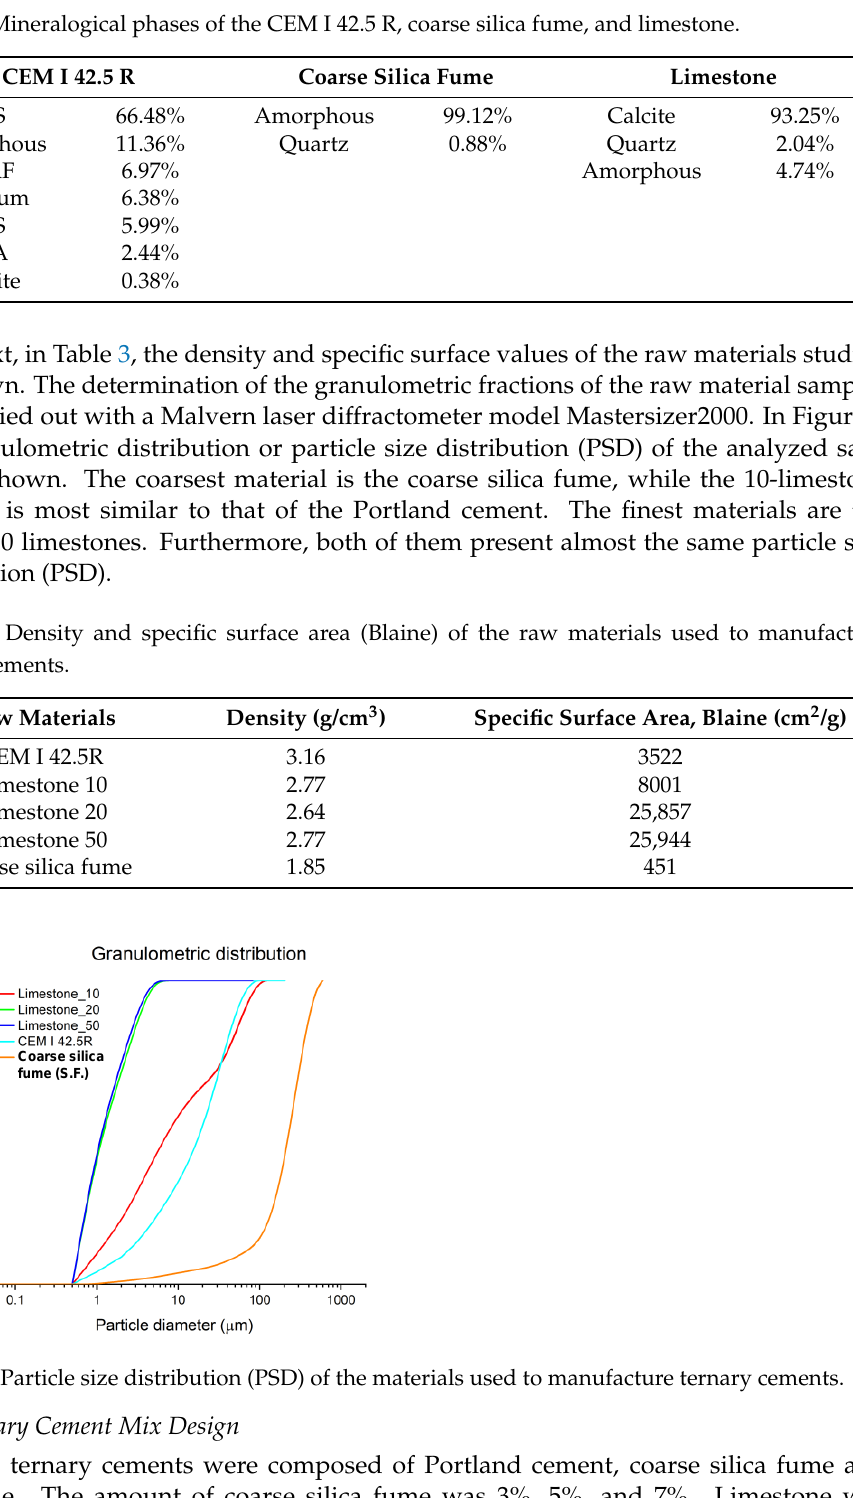
Table 2. Mineralogical phases of the CEM I 42.5 R, coarse silica fume, and limestone.